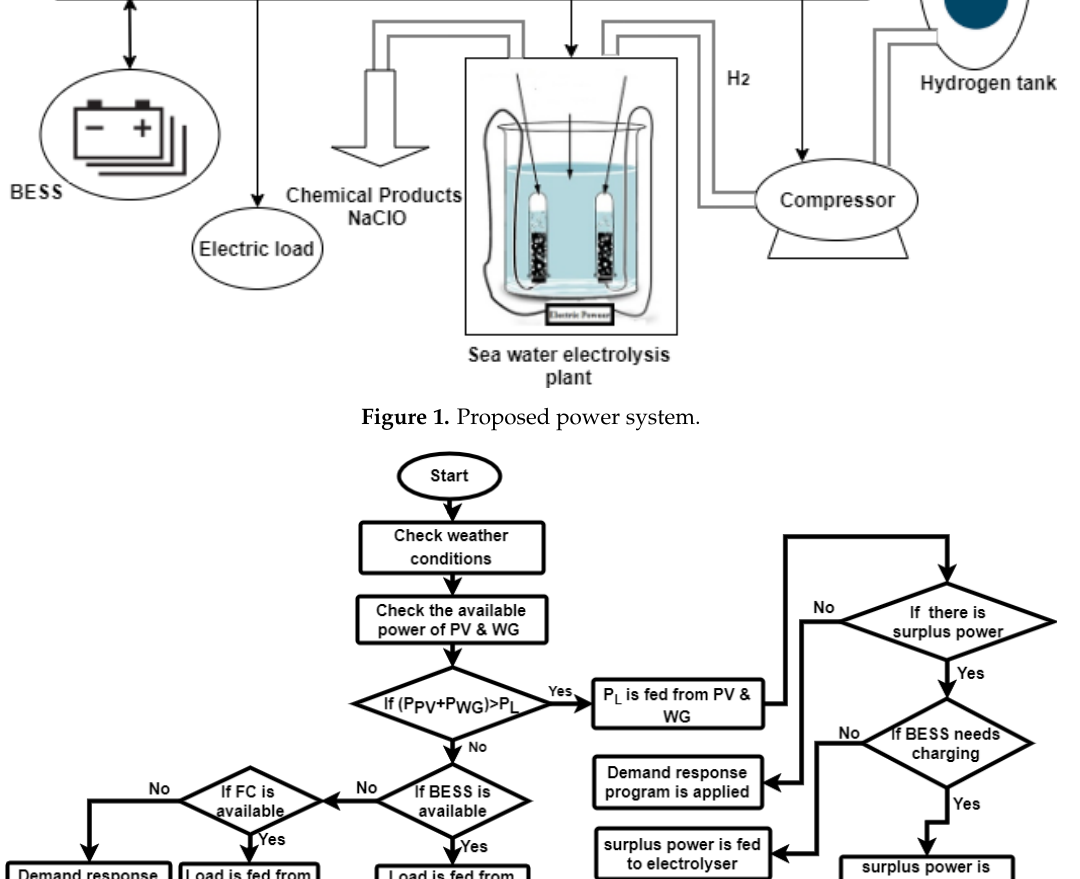
Figure 2. The flow chart of the system ordinary